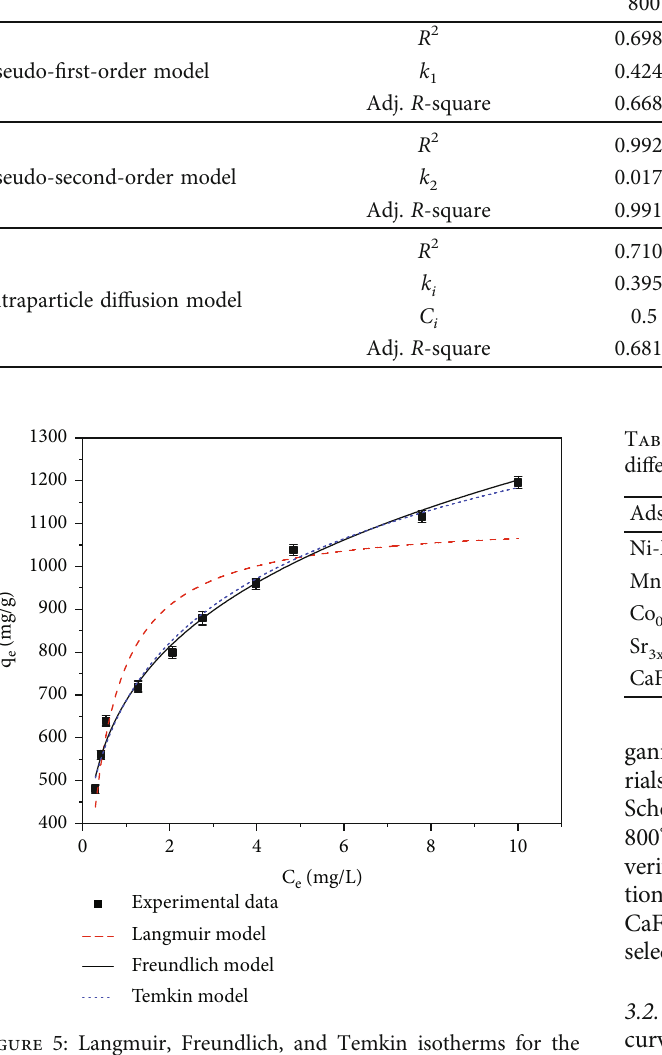
Table 1: Adsorption kinetics parameters of magnetic CaFe Kinetics model